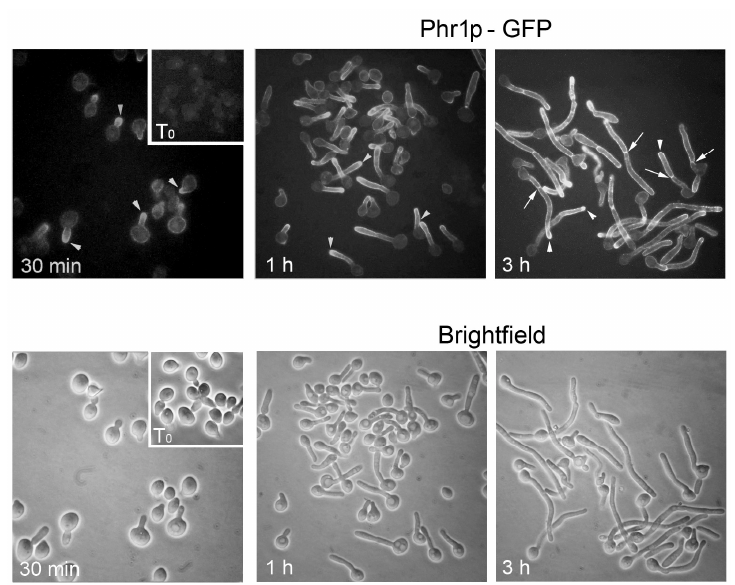
Figure 7. Localization of Phr1p-GFP in C. albicans . Phr1p-GFP localization in conditions of induction of hyphal growth in M199–150 mM HEPES, pH 7.5 at 37 °C. Modified from [57].